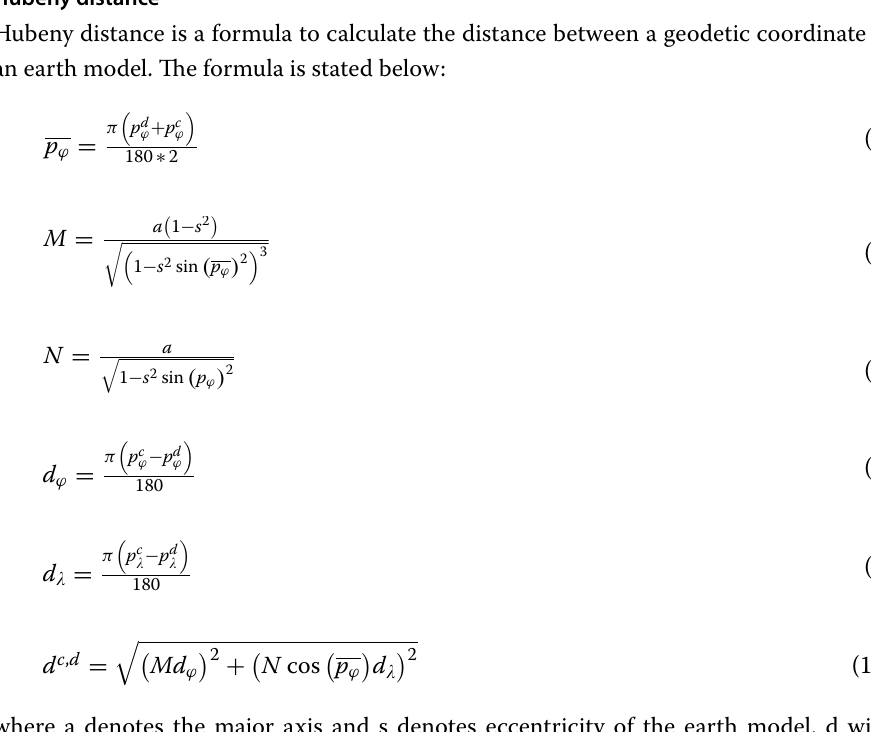
where B denotes the bearing, p is a geodetic coordinate with superscript c denotes cur- rent geodetic coordinate, and d denotes destination coordinate, and the subscript denotes longitude, and subscript ϕ denotes latitude [17].